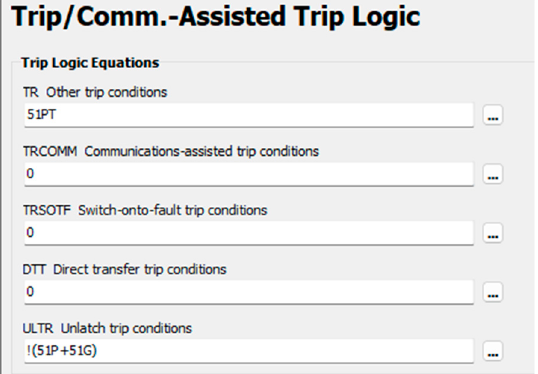
Figure 6. Trip logic equation for R1 and R2 under IDMT scheme.